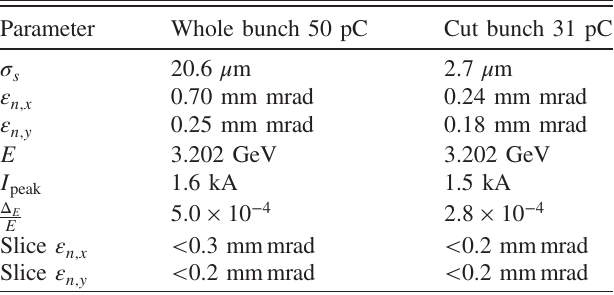
TABLE VI. S2E final beam parameters.